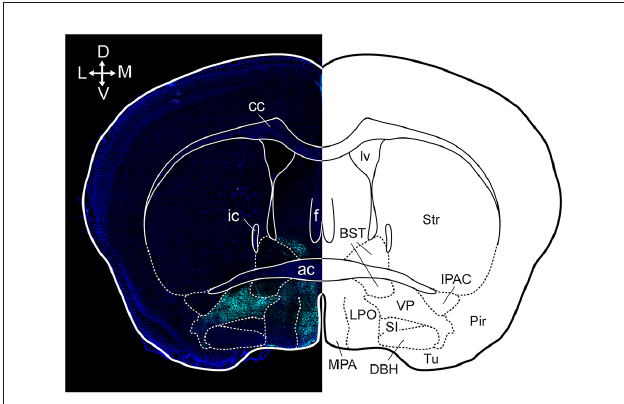
FIGURE1 Anatomical localization of the VP in a coronal section. Dense substance P immunoreactivity (cyan) delineates the VP from surrounding basal forebrain regions and the section is counterstained with DAPI (blue). cc, corpus callosum; ic, internal capsule; ac, anterior commissure; f, fornix; lv, lateral ventricle; BST, bed nucleus of the stria terminalis; Str, striatum; MPA, medial preoptic area; LPO, lateral preoptic area; SI, substantia innominate; DBH, horizontal limb of the diagonal band; VP, ventral pallidum; Tu, tubercle; Pir, piriform cortex; IPAC, interstitial nucleus of the posterior limb of the anterior commissure. Arrows indicate the orientation of the brain along the dorsoventral (DV) and mediolateral (ML) axes. Figure adopted from Heinsbroek et al. (2020) and Paxinos and Franklin